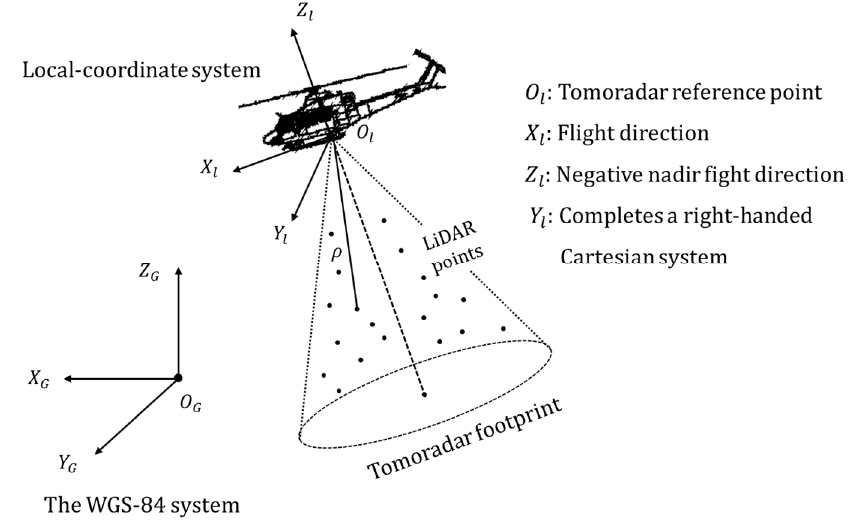
Figure 3. The definition of local-coordinate system and the relationship with the WGS-84 system. The Tomoradar reference point is regarded as the transmitted point of Ku-band microwave, which can be approximately expressed with a geographical coordinate of the GNSS system. The axis directions of the local coordinate system in WGS-84 system are designated with attitude angles of the IMU system attached on the